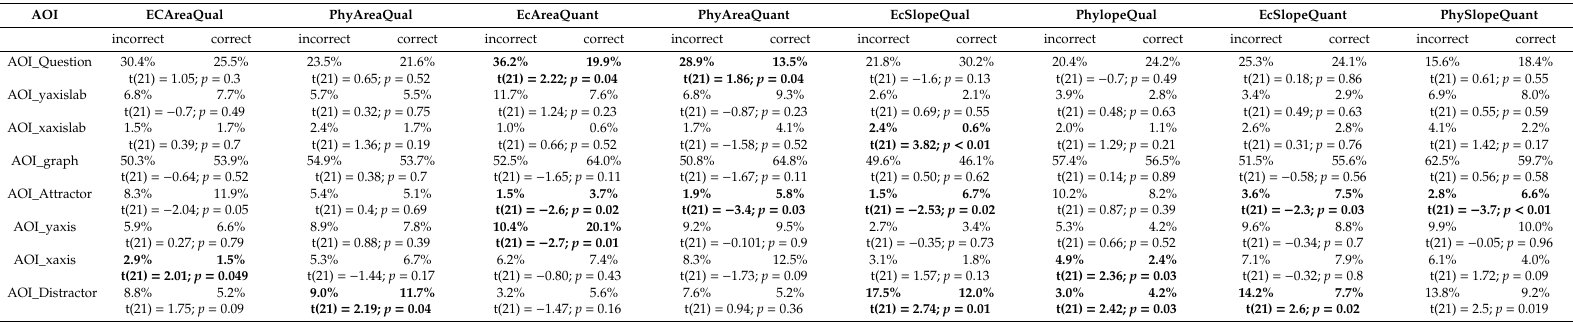
Table A1. Average number of fixations of correct and incorrect solvers for each task including values of the T -tests (significant di ff erences in bold). AOI ECAreaQual PhyAreaQual